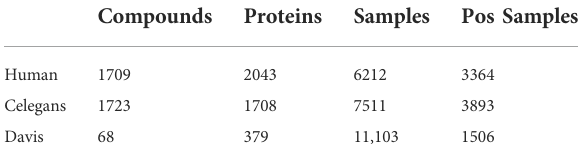
TABLE 1 Summary of the